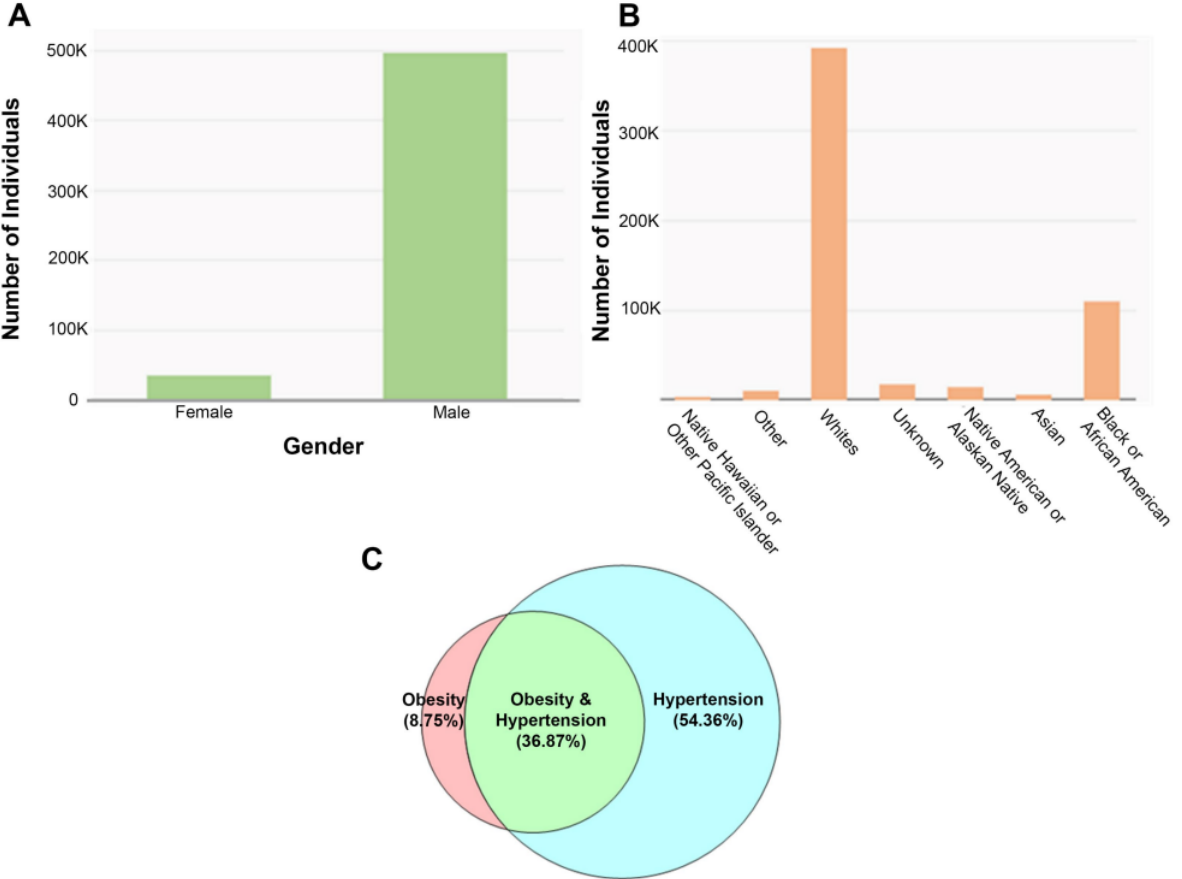
Figure 2. Prevalence of hypertension and obesity as extracted from MVP database. The number of veterans with hypertension based on ( A ) gender and ( B ) racial demographics. ( C ) A Venn diagram depicting the prevalence of hypertension, obesity, and both hypertension and obesity together in the veteran population.